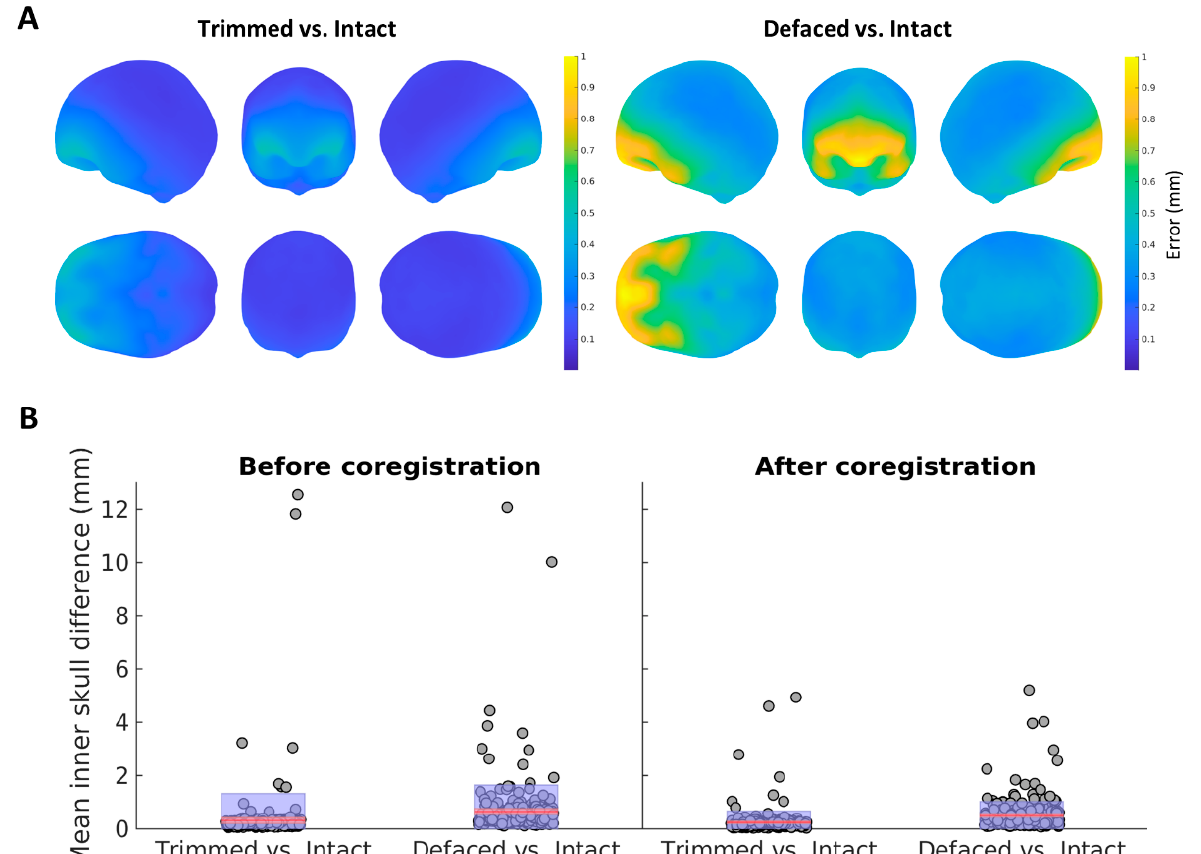
Figure 4. ( A ) Distribution of the error (in millimetres) between the inner skull surface generated from one participant’s Intact MRI and that generated from either their Trimmed ( left ) or De-faced ( right ) MRIs. ( B ) Distribution of mean errors across participants before ( left ) and after ( right ) applying a rigid body coregistration of the meshes. The figure shows the median error (in red) and the standard deviation (blue shadowed area) for the mean difference between the surface mesh generated from the Intact MRI and either the Trimmed or the De-faced MRIs.